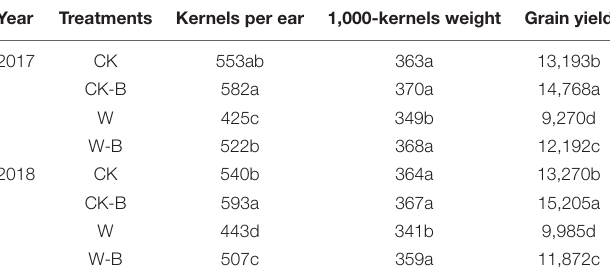
TABLE 1 | The effects of 6-BA on the yield of waterlogged summer maize. Year Treatments Kernels per ear 1,000-kernels weight Grain yield